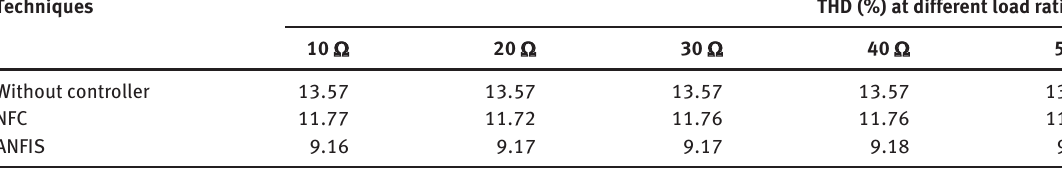
Table 2: Comparison of THD.